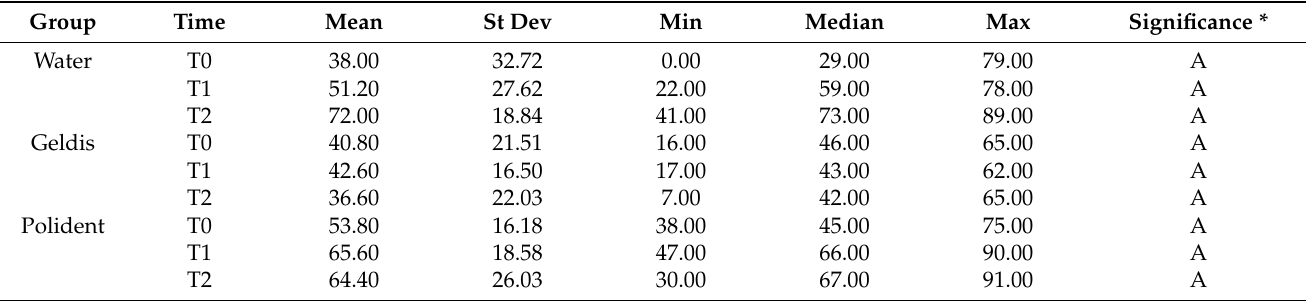
Table 2. Descriptive statistics of Plaque Control Record measurements (PCR%).